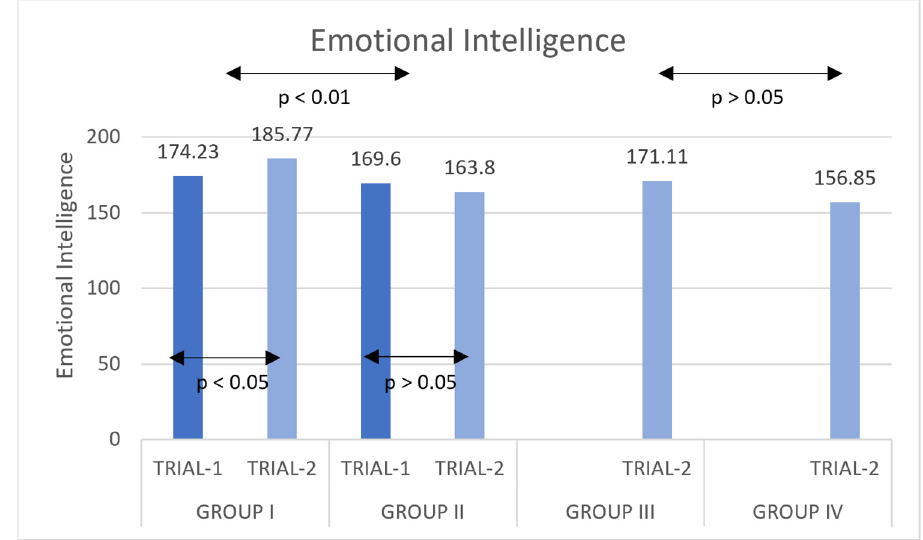
Figure 2. Mean values of the scale emotional intelligence quotient (x ± SD) pre-test/Trial-1 and post-test/Trial-2 training in DSN. post-test/Trial-2 training in